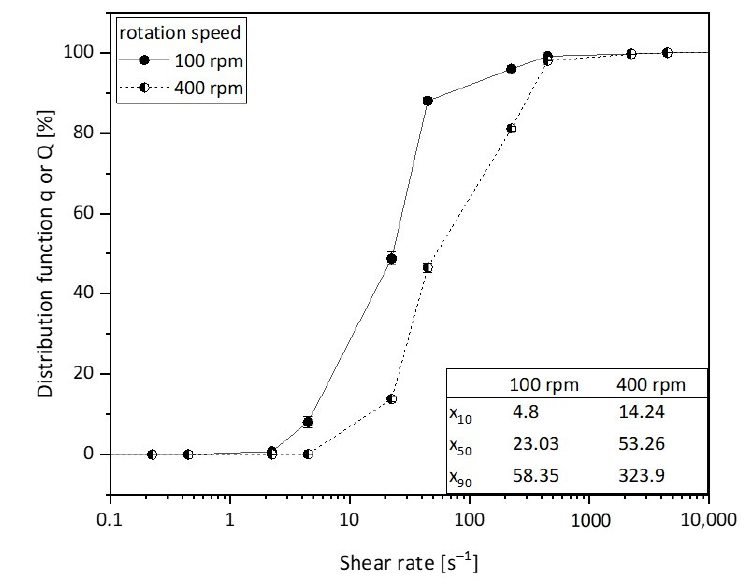
Figure 9. Representation of the simulated shear rate distributions of the fluids at 100 rpm and 400 rpm.